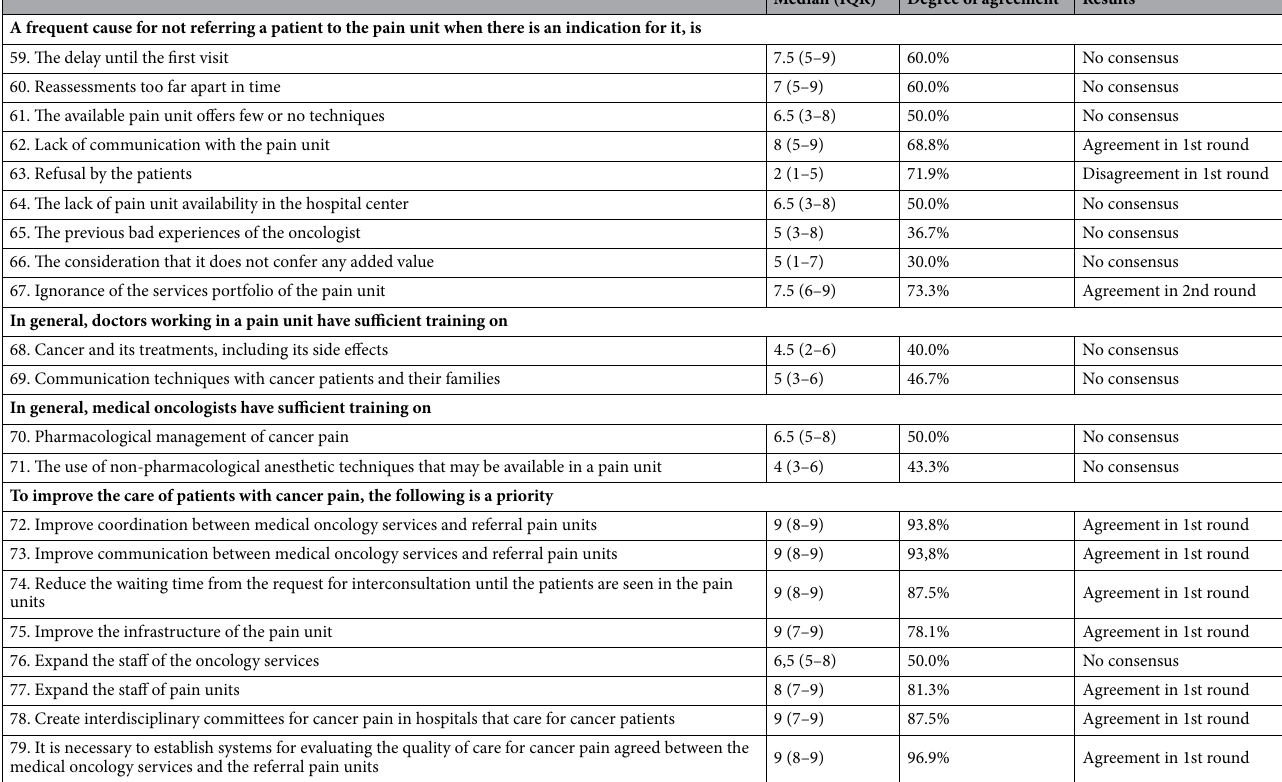
Table 3. Block III results. Barriers and opportunities for cancer pain management improvement. * IQR interquartile